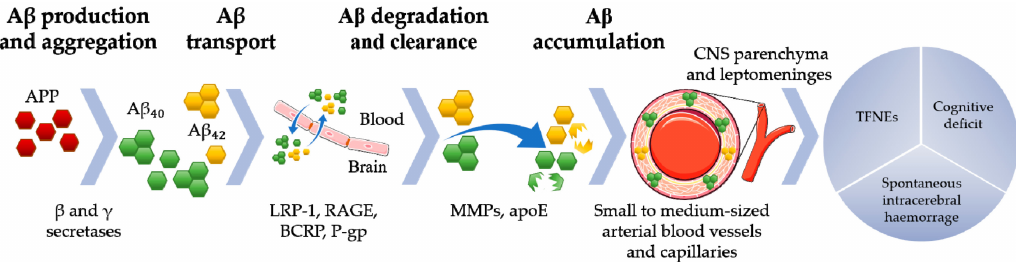
Figure 1. Amyloid precursor protein (APP) is cleaved in the amyloidogenic pathway by β and γ secretases to form amyloid beta (A β ) A β 40 and A β 42 peptides. A β 40 is the main peptide associated with cerebral amyloid angiopathy. These peptides are transported across the blood brain barrier (BBB) through membrane receptors and transporters (i.e., low density lipoprotein receptor-related protein 1, LRP-1; receptor advanced glycation end products, RAGE; breast cancer resistance protein, BCRP; permeability glycoprotein, P-gp) and degraded by specific enzymes, such as matrix metallopeptidases (MMPs) and apolipoprotein E (apoE). The accumulation of amyloid fibrils in the walls of the small- and medium-calibre leptomeningeal and cortical arteries may result from increased production and impaired transport and degradation of A β peptides. This aberrant pathway causes spontaneous intracerebral haemorrhage, cognitive decline and transient focal neurological events (TFNEs; CNS, central nervous